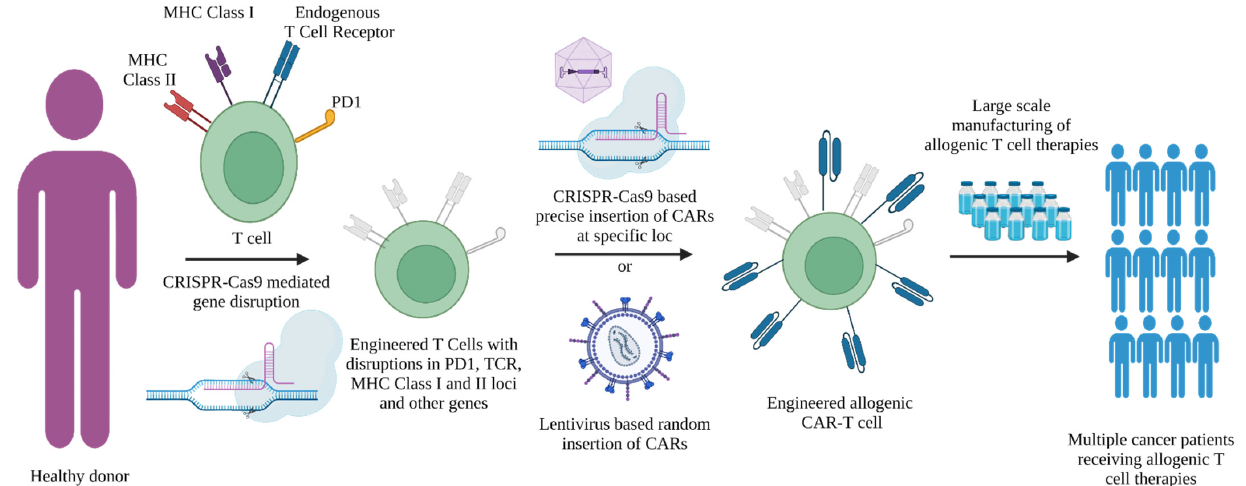
Figure 3. A scheme of CRISPR-Cas9 engineering in the allogenic CAR-T therapy. T cells are extracted from healthy donors and engineered with CRISPR-Cas9 technology to edit select genes including genes for TCR, PD1, and MHC Class I and II molecules, among others. Later, CAR is randomly inserted into the genome via lentivirus or precisely inserted at a target locus via the CRISPR-Cas9 system to create an engineered allogenic off-the-shelf CAR-T cell. These donor-derived allogenic CAR-T cells are manufactured in scale and given back to multiple cancer patients.